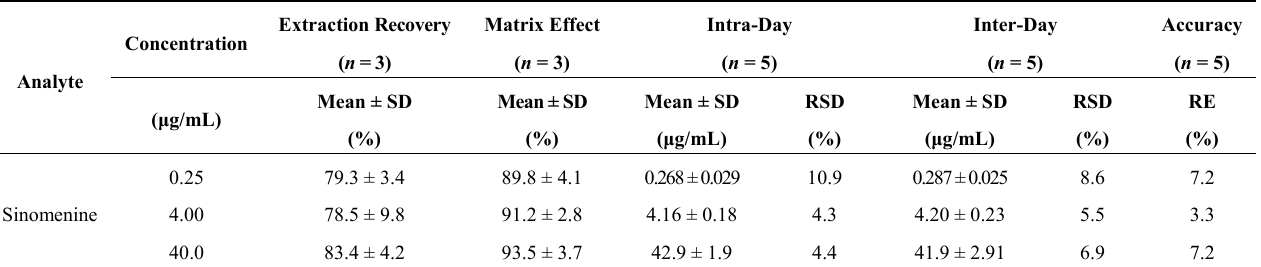
Table 1. Extraction recovery, matrix effect, intra-day and inter-day precision and accuracy data from HPLC analysis of